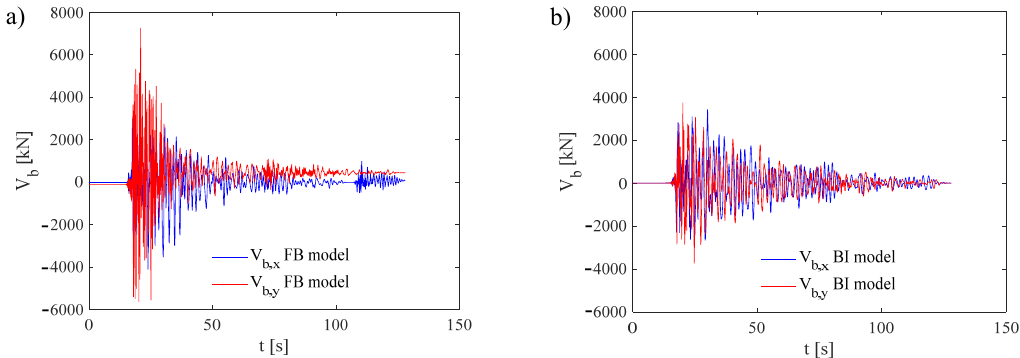
Figure 10. Base shear comparison along the two directions: FB model ( a ), BI model ( b ).